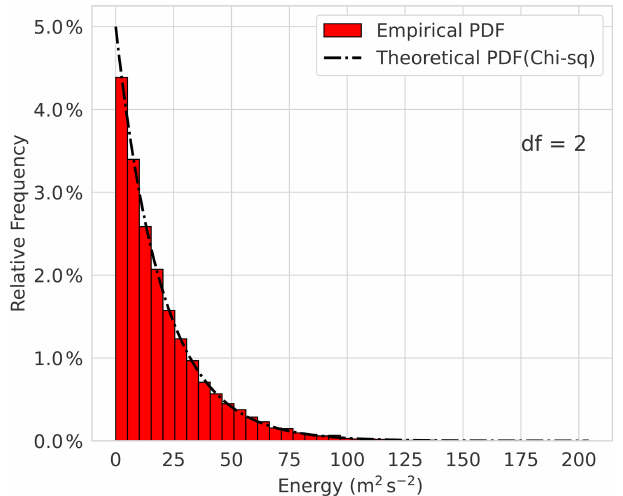
Figure 2. Atmospheric energy distribution for the Rossby wave with the zonal wavenumber k = 7, meridional mode n = 3, and ver- tical mode index m = 1 in ERA5 for 1980–2014. The dashed black lines correspond to the theoretical χ 2 distribution (df represents the degrees of